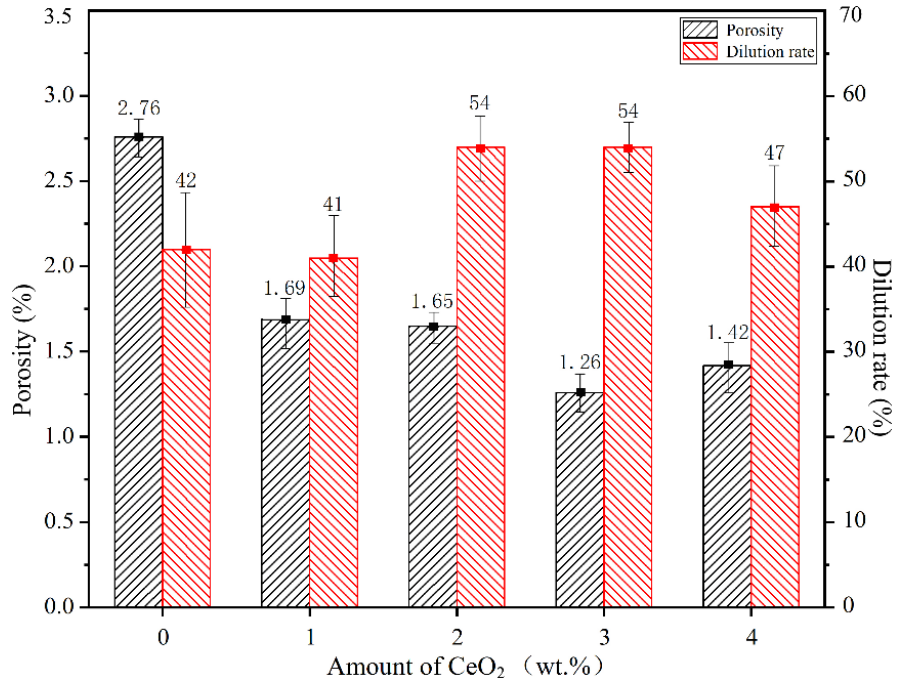
Figure 3. The dilution rates and the porosity of the laser cladding coatings.